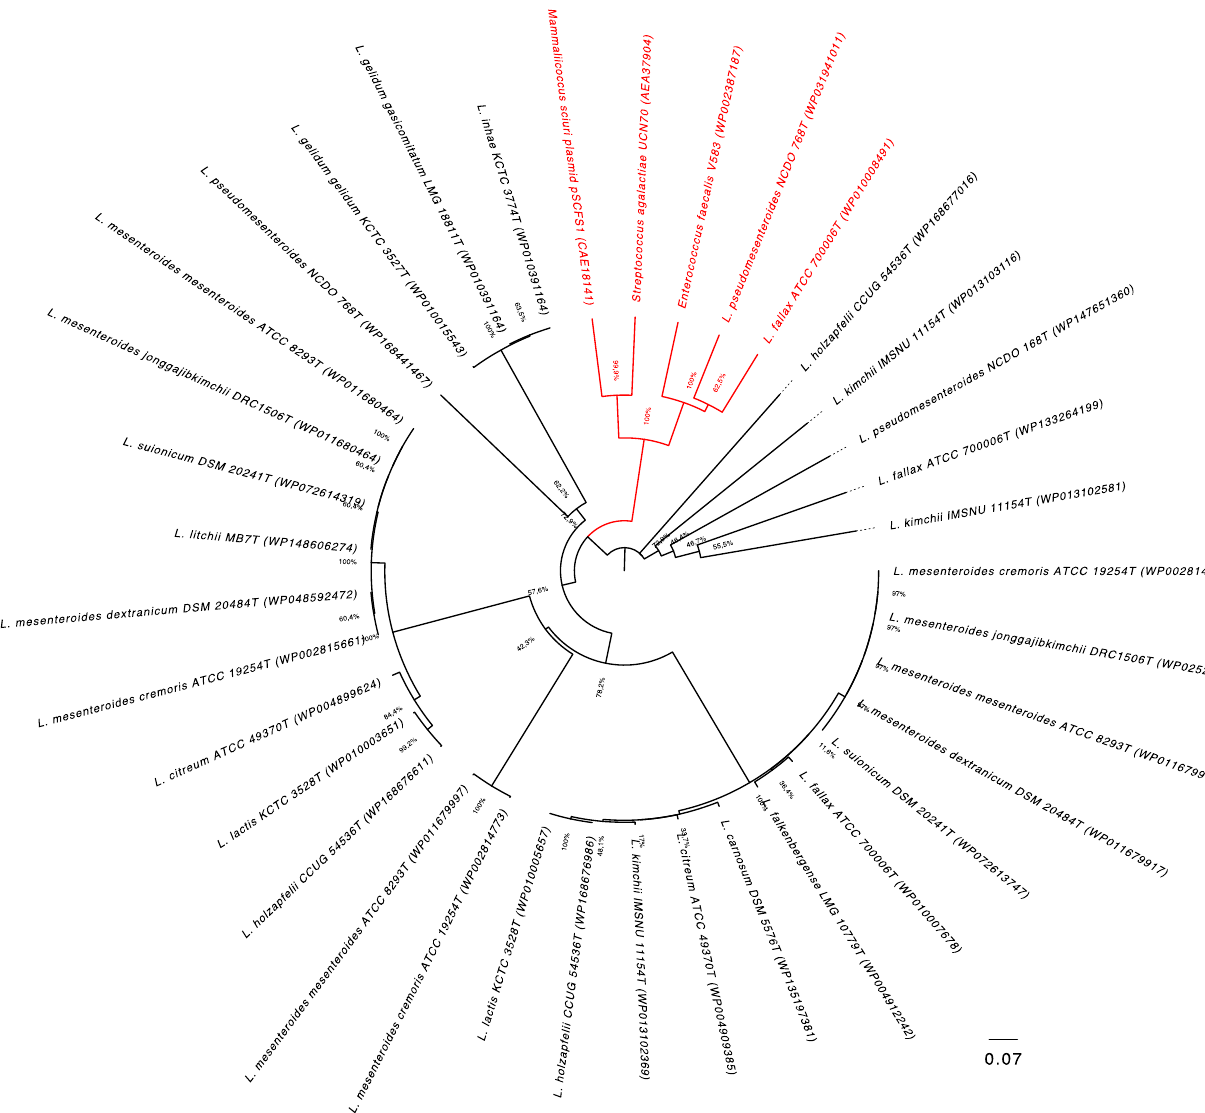
Figure 2. Evolutionary relationships of LsaA, LsaB and LsaC proteins in Leuconostoc type strains. The evolutionary history was inferred using the UPGMA method [38]. The percentage of replicate trees in which the associated taxa clustered together in the bootstrap test (1000 replicates) are shown next to the branches [39]. The tree is drawn to scale, with branch lengths in the same units as those of the evolutionary distances used to infer the phylogenetic tree. The evolutionary distances were computed using the Poisson correction method [40] and are in the units of the number of amino acid substitutions per site. All positions containing gaps and missing data were eliminated (complete deletion option). Evolutionary analyses were conducted in MEGA X [41,42] by using Enterococcus faecalis V583, Mammaliicoccus sciuri (plasmid) pSCFS1 and Streptococcus agalactiae UCN70 as outgroups. The phylogenetic group including LsaA of L. pseudomesenteroides NCDO 768 T and L. fallax ATCC 700006 T is highlighted in red.